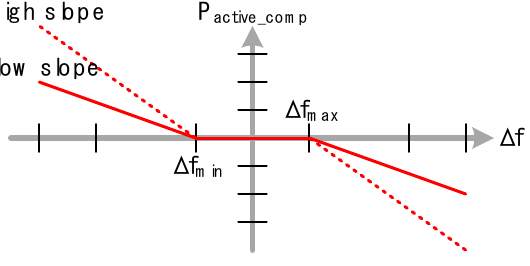
Figure 2. Frequency-active power droop.